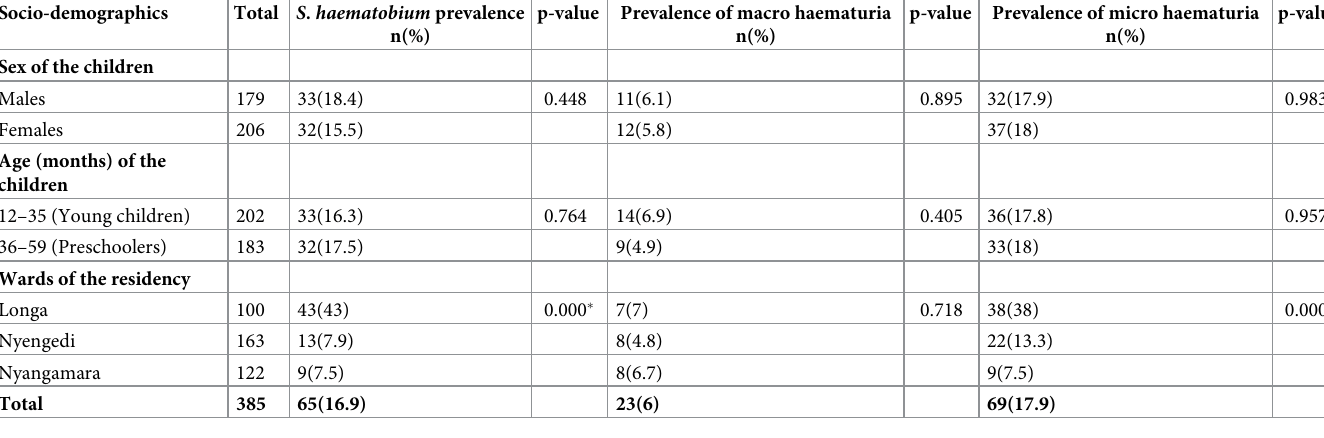
Table 2. Prevalence of urogenital schistosomiasis by urine microscopy, macro and microhaematuria stratified according to socio-demographic characteristics of the study participants (n = 385).